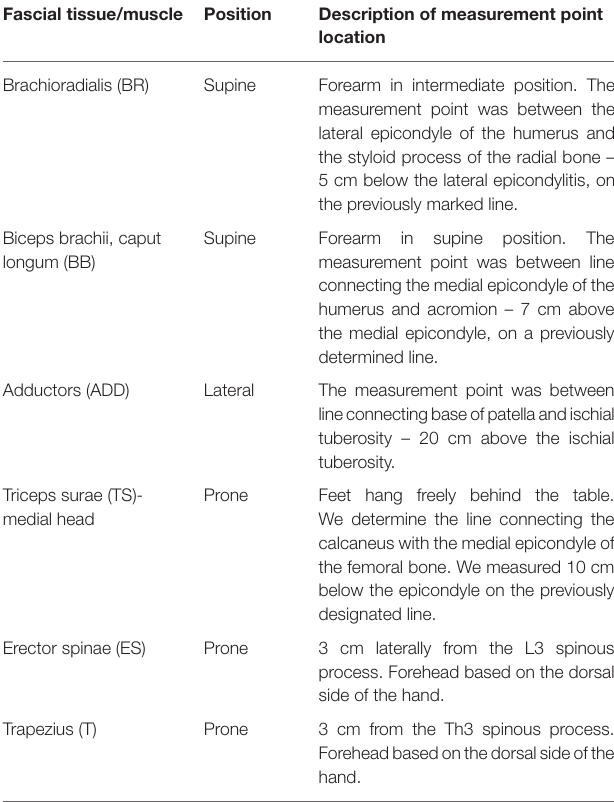
TABLE 1 | Description of measurement fascial tissue (FT) point location in participants’ supine, lateral, and prone